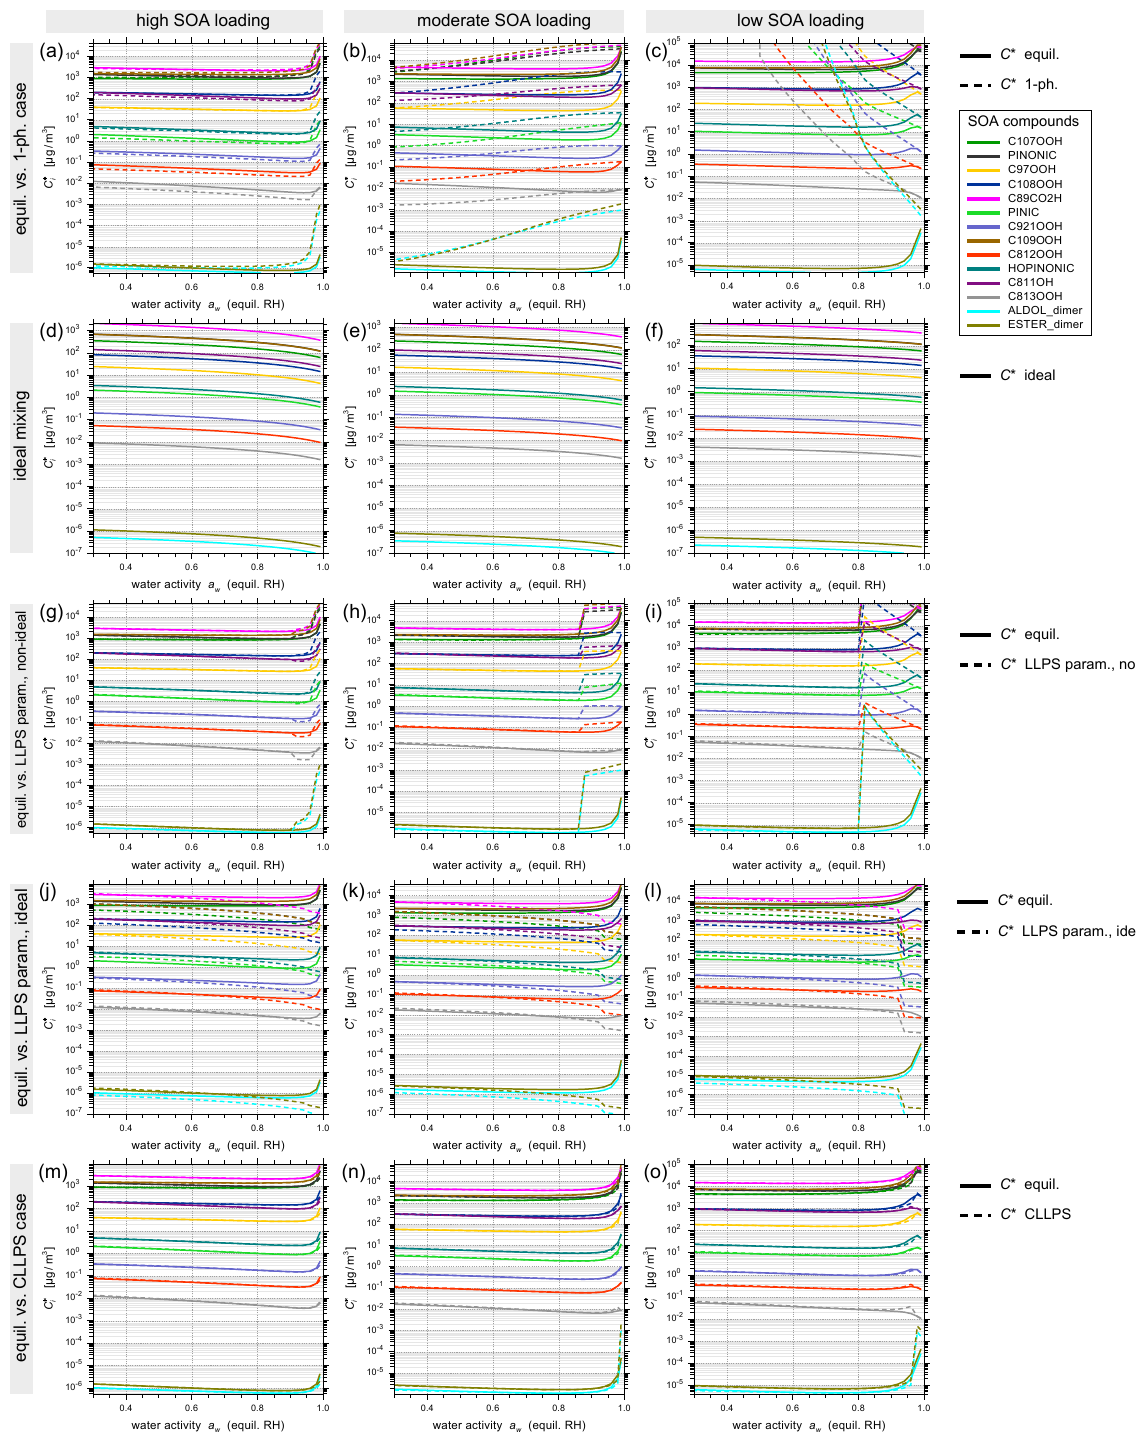
Fig. 7. Effective saturation concentrations, C ∗ (Eq. 5), of the organic system components as a function of RH at 298K. Comparison of the different modeling cases with the benchmark (equil.) case for predicted partitioning at three distinct SOA loading levels (see Fig. 5). The effect of a high PM water content at high RH on the C ∗ values is especially prominent for less hydrophilic (low O : C) components, e.g. PINONIC and the